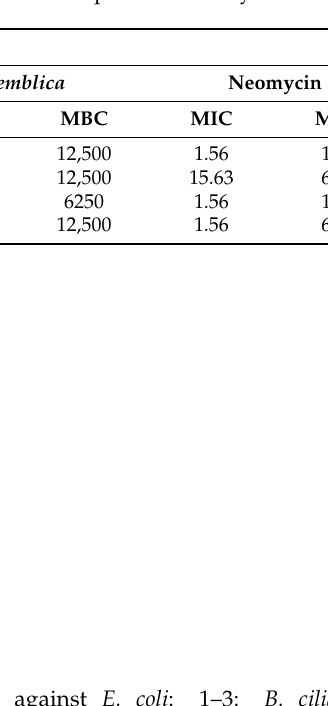
Figure 2. Antibacterial assays of plant extracts against Staphylococcus aureus ATCC 25923, Escherichia coli ATCC 25923, Salmonella typhi ATCC 14028, and Shigella sonnei ATCC 25931. Table 3. Zone of inhibition of different solvent fractions of plant extracts against B. ciliata , M. pudica , and P. emblica .